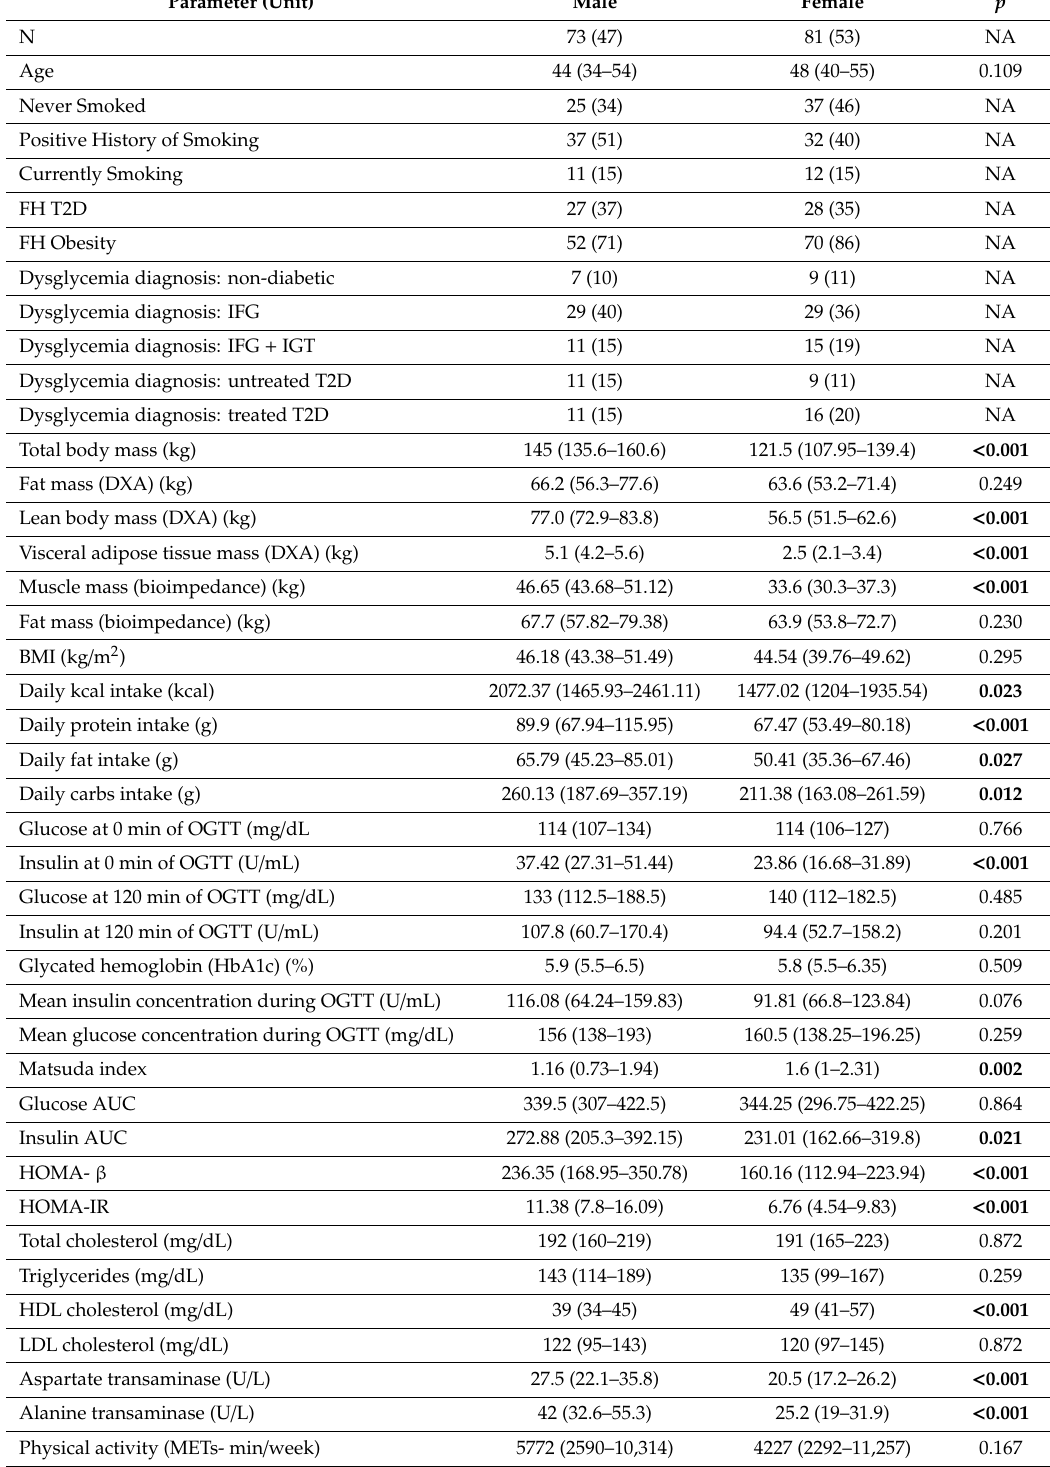
Table 2. Baseline characteristics for the study cohort cross-sectioned by